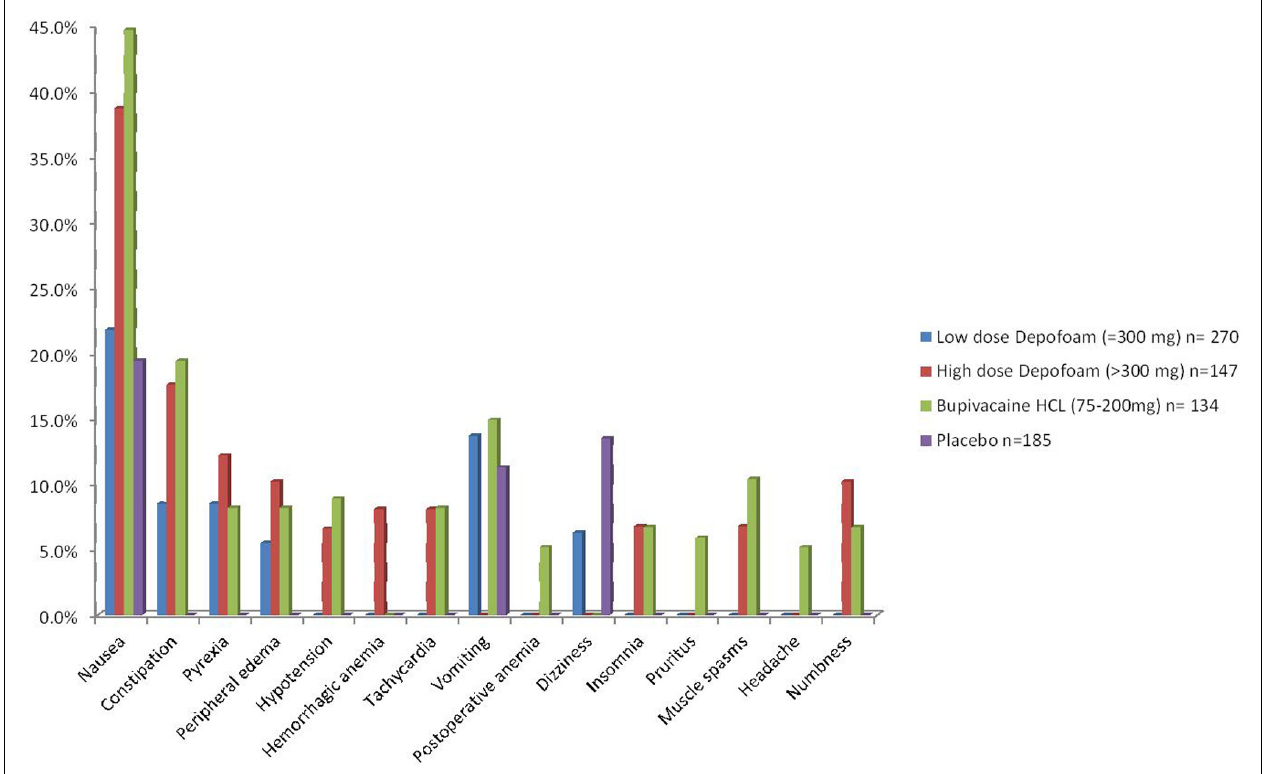
FIGURE 1 | Most common adverse effects reported (incidence above